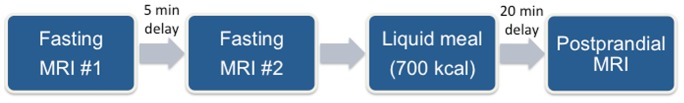
Study design.All subjects were scanned twice after 6 hours of fasting to assess short-term reproducibility of MRI metrics (subjects were removed from the MRI system and re-imaged). Subjects were then scanned again in postprandial conditions, 20 min. after a 700 kcal liquid meal.